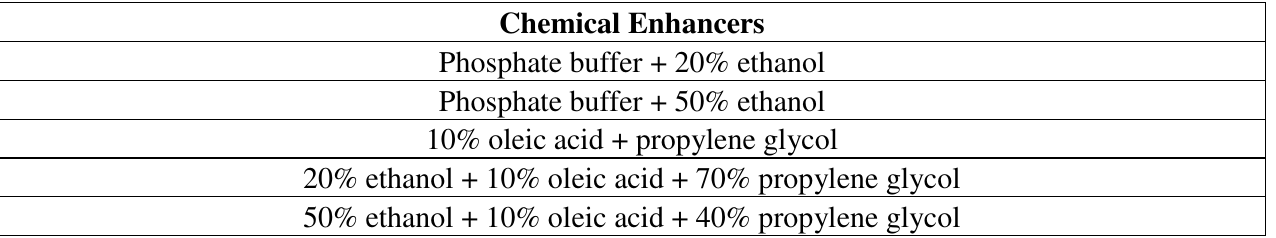
Table 1. List of chemical enhancers investigated for enhanced cyanocobalamin